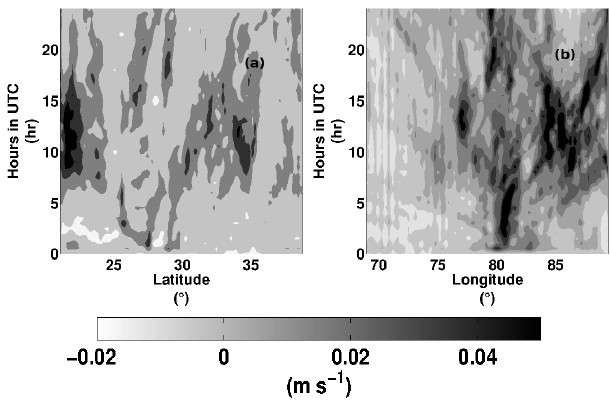
Figure 9. Model-simulated (a) longitudinally averaged vertical ve- locity, and (b) latitudinally averaged vertical velocity for Uttarkashi during 3 August